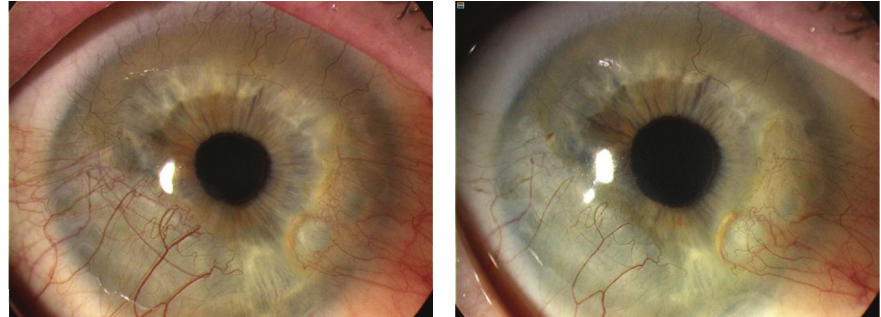
Figure 2: Representative case of corneal neovascularization treated with subconjunctival injection of bevacizumab. Patient was a 63- year-old female with chronic keratoconjunctivitis and rheumatoid arthritis. The baseline photograph shows circumferential (360 degrees) neovascularization (NV) of cornea (left). Six months after subconjunctival bevacizumab treatment, NV decreased significantly (right).